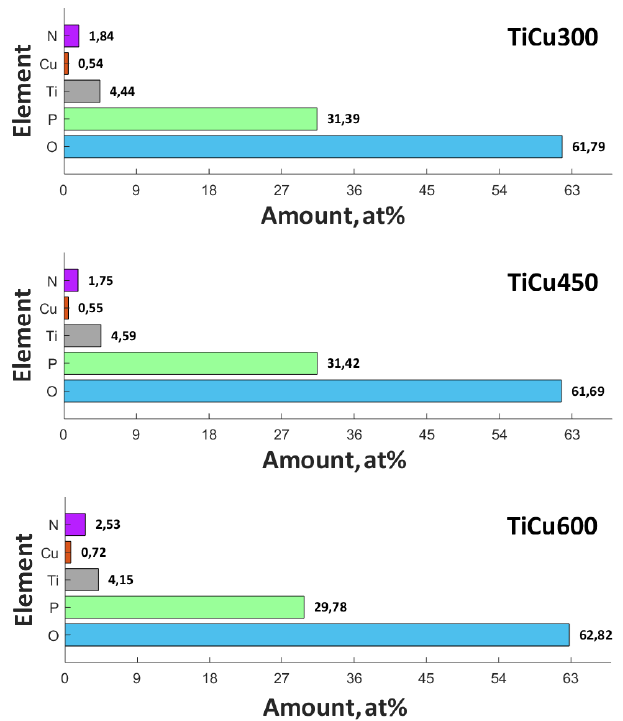
Figure 5. The quantitative analyses of XPS results of the three coatings: TiCu300, TiCu450, and